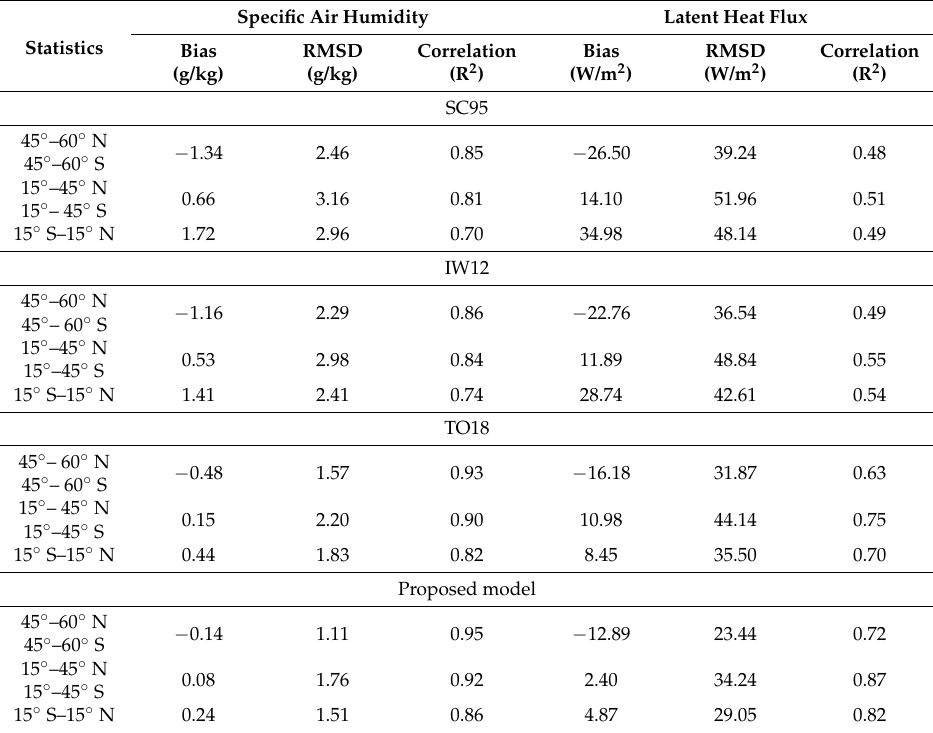
Table 4. Comparisons between satellite and in situ data for the four algorithms.